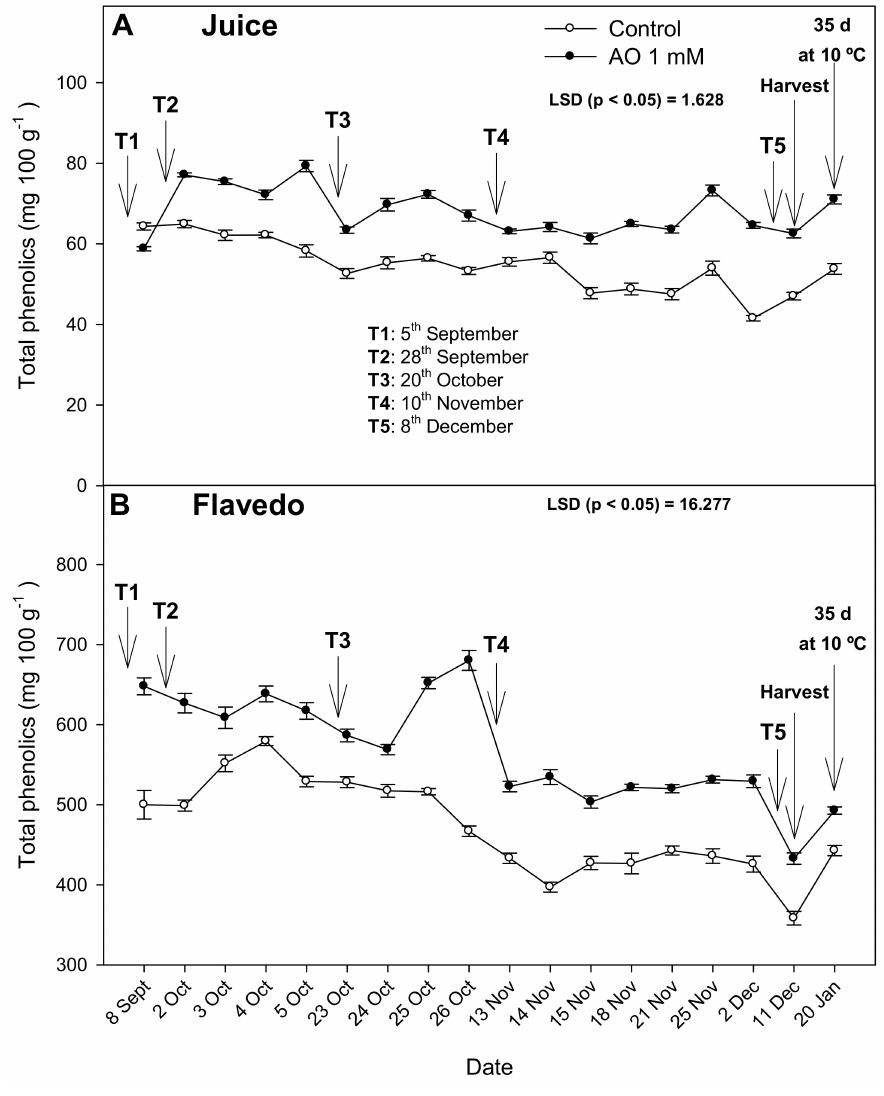
Figure 2. Total phenolic content in juice ( A ) and flavedo ( B ) during fruit growth and ripening on the tree, at harvest, and after 35 days of storage at 10 ◦ C of lemons from the control and oxalic acid (OA) treated trees in the 2020 experiment. Data are the mean ± SE of four replicates. LSD show significant differences at p < 0.05. T1, T2, T3, T4, and T5 show the dates of the